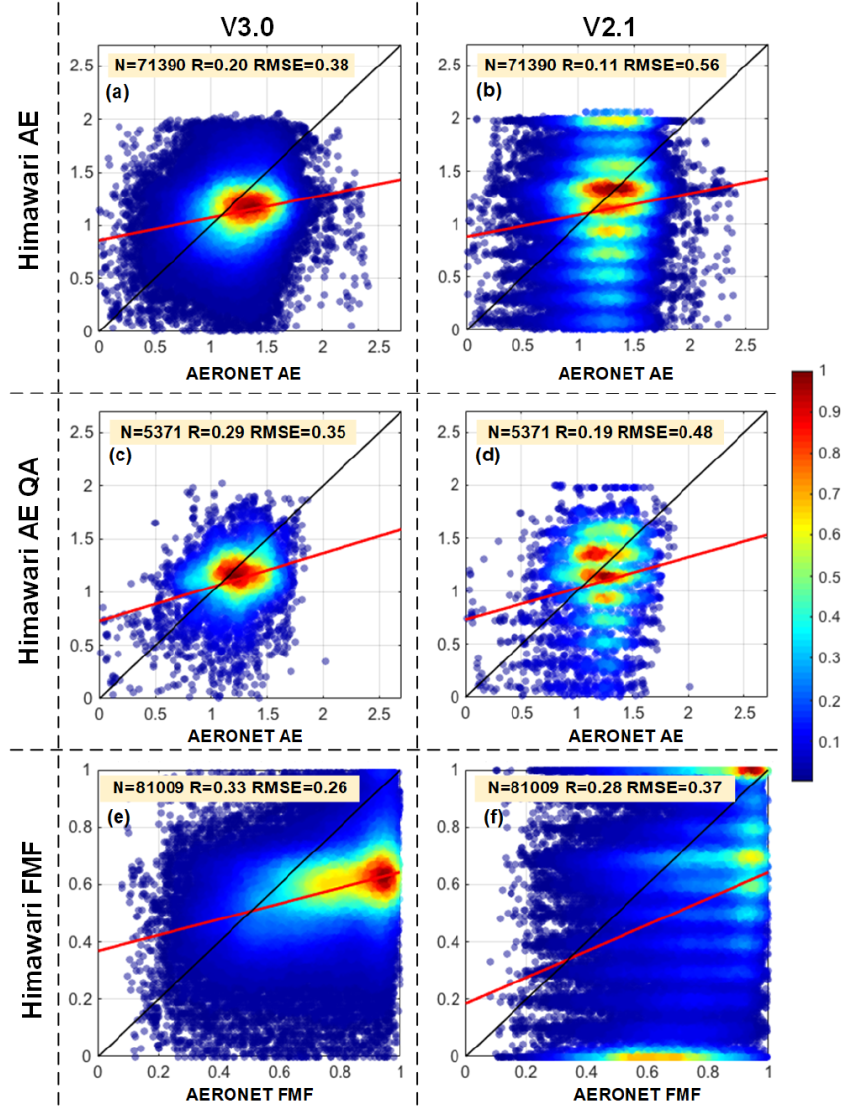
Figure 5. Density scatter plots of the Himawari-8 AE ( a , b ), Himawari AE after quality control (AE QA) ( c , d ), and Himawari FMF ( e , f ) with their ground-based AEROENT values for both V3.0 and V2.1 data. The black and red lines represent 1:1 and fitting lines, respectively.